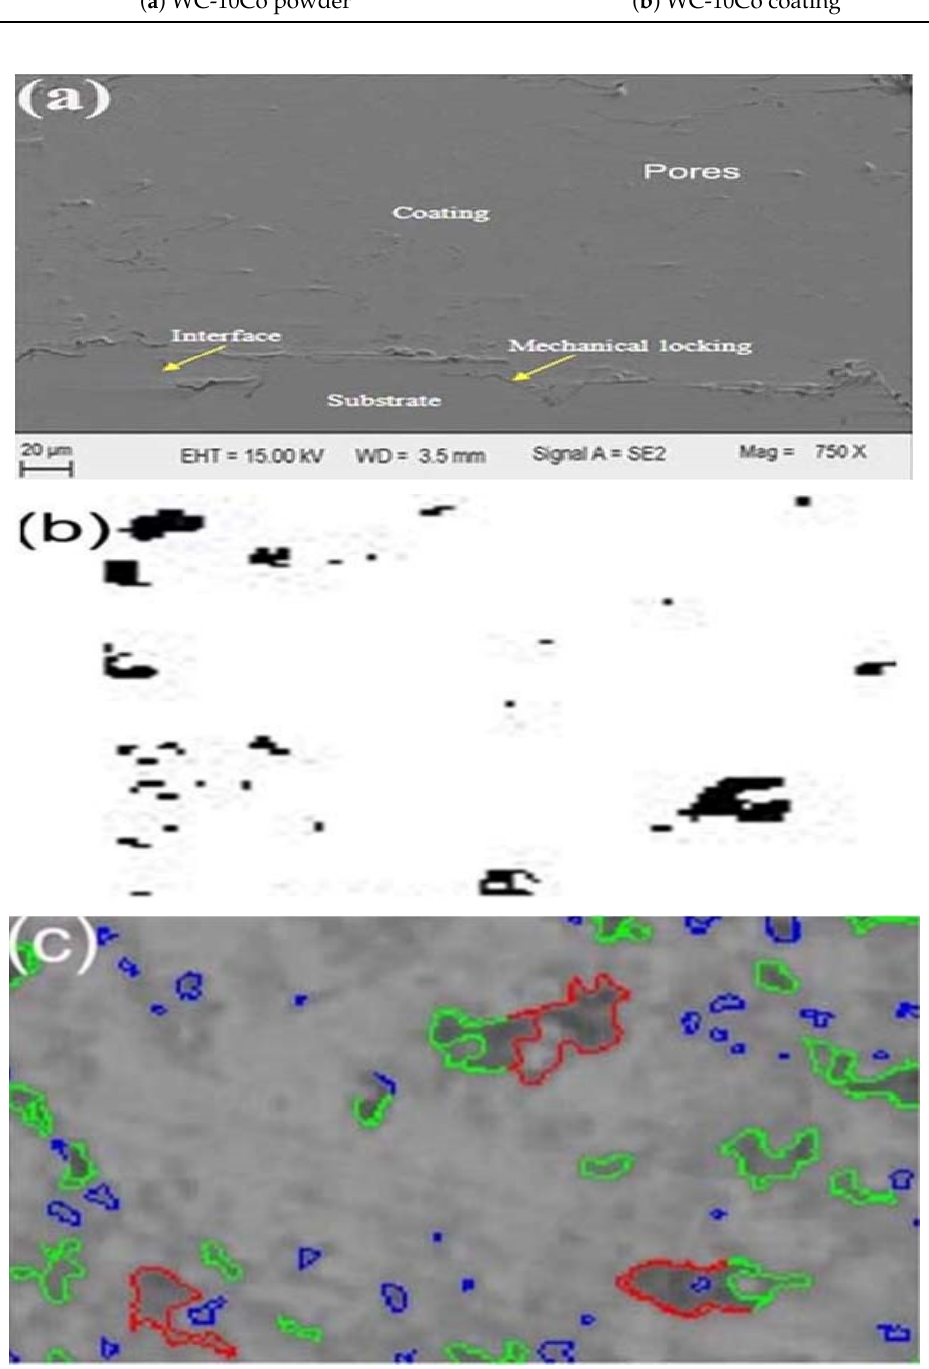
Figure 3. Porosity analysis. ( a ) Cross sectional image; ( b ) Binary image; ( c ) Color coded image.